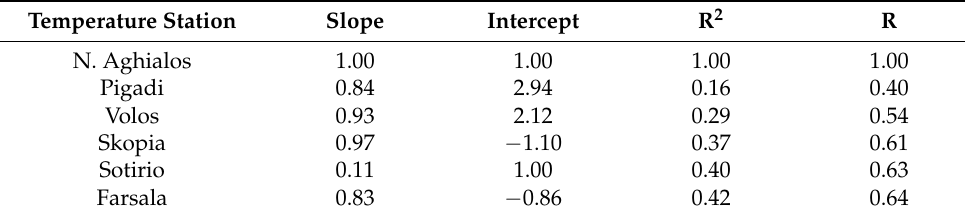
Table 4. Linear regression coefficients of the stations for the temperature variable.